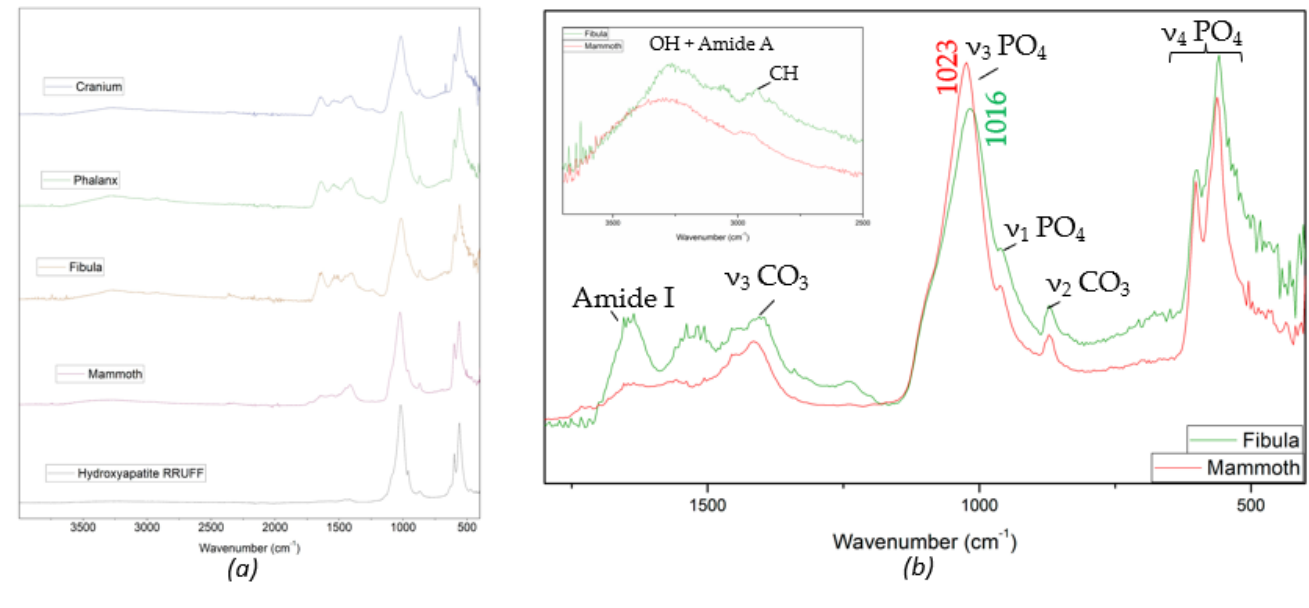
Figure 4. FTIR analyses of bone samples. ( a ) FTIR spectra (450 – 4000 cm −1 ) for all studied bone samples and reference spectra of hydroxyapatite obtained from RRUFF database. ( b ) FTIR spectra comparison between recent elephant’s fibula (green) and femur of a mammoth (red) displaying characteristic bands corresponding to the main molecular compounds of bone mineral. Inset a detailed section of FTIR spectra (2500 – 400 cm − 1 ) corresponding to the OH + CH domains. Table 5. Degree of mineralization (PO 4 /amide I), amount of carbonate to organic matrix (CO 3 _1415/amide I), carbonate to phosphate mineral content (CO 3 _1415/PO 4 ), and carbonate in the bone mineral and substituted carbonate (CO 3 _1415/CO 3 _870) determined by ATR-FTIR spectromet- ric analyses.